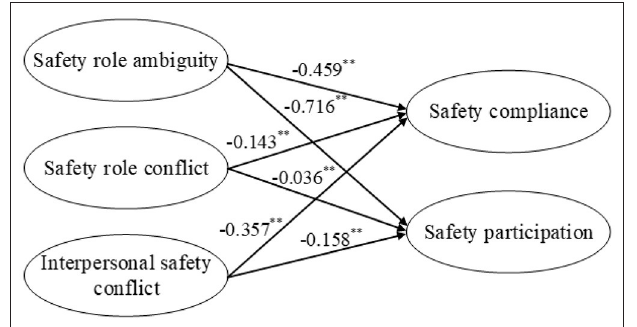
FIGURE 5 | Direct effects of ego depletion on safety performance and self-efficacy. ** p < 0.01.